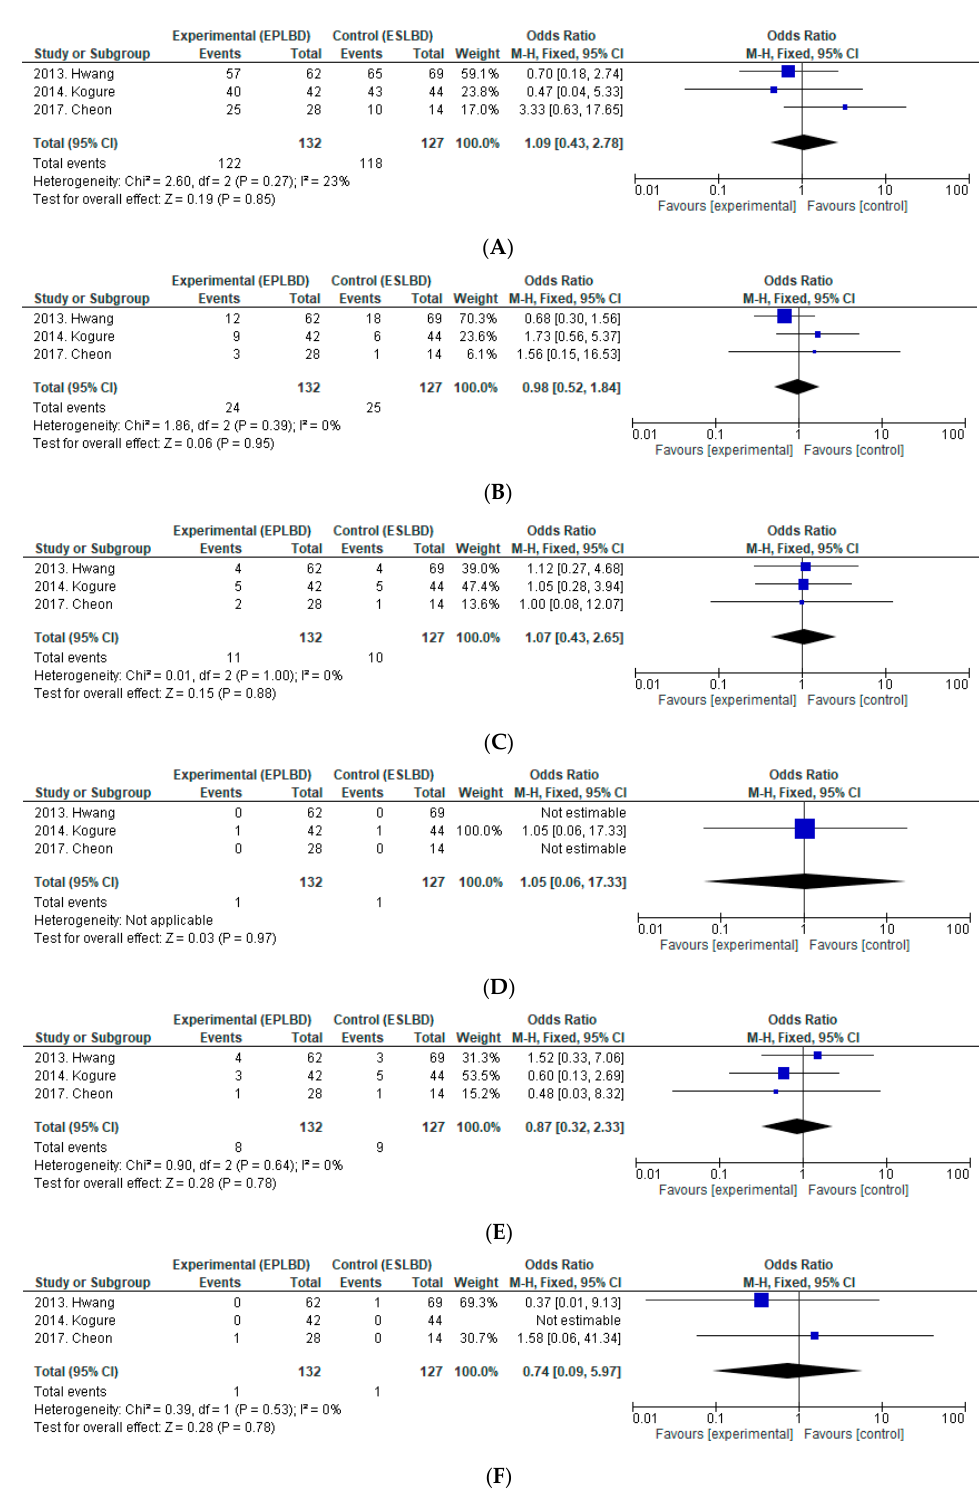
Figure 3. Forest plot of risk ratios and 95%CIs representing a comparison between EPLBD and ESLBD. ( A ): Complete stone removal in the first endoscopic session. ( B ): Rate of mechanical lithotripsy. ( C ): Overall adverse events. ( D ): Bleeding. ( E ): PEP. ( F ): Perforation. CI, Confidence interval; EPLBD, endoscopic papillary large balloon dilation without endoscopic sphincterotomy; ESLBD, endoscopic papillary large balloon dilation with endoscopic sphincterotomy; PEP, post-endoscopic retrograde cholangiopancreatography pancreatitis.